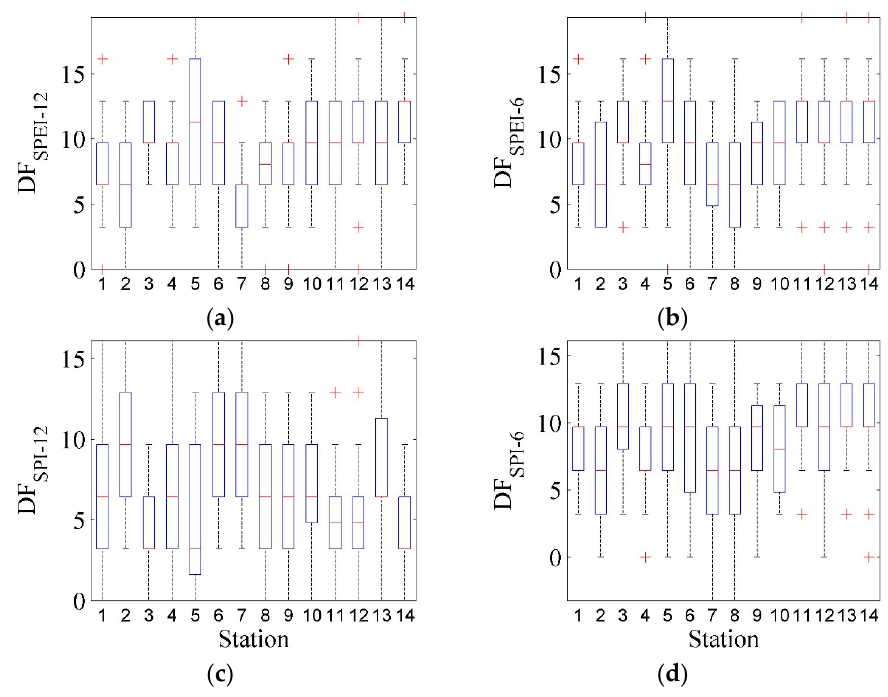
Figure 9. Percentage drought events per year across the Free State and North West Provinces. ( a ) Drought frequency computed using SPEI 12 values; ( b ) drought frequency computed using SPEI 6 values; ( c ) drought frequency computed using SPI 12 values and ( d ) drought frequency computed using SPI 6 values.